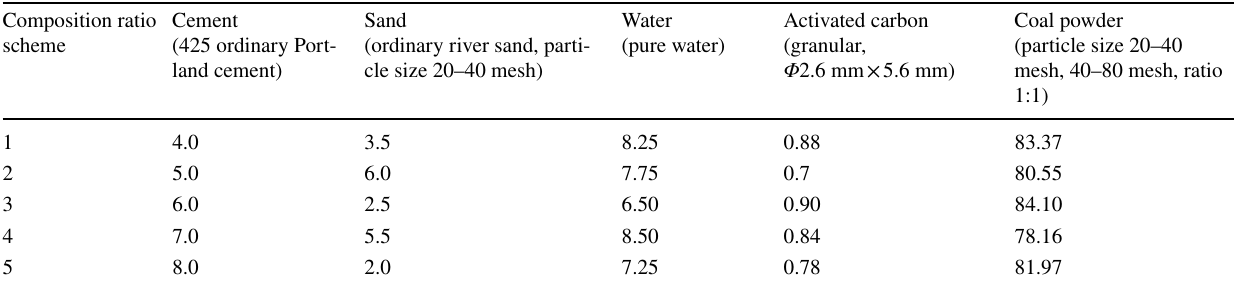
Table 2 Composition of prepared coal samples Composition ratio